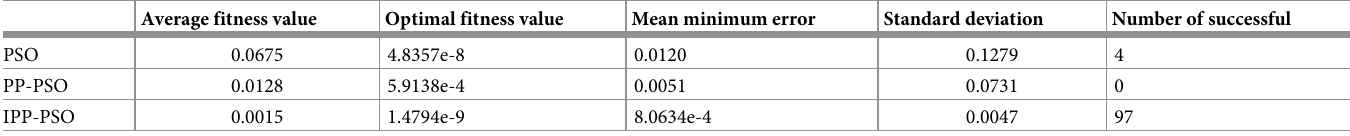
Fig 7. Average error simulation results of two-person zero-sum game. https://doi.org/10.1371/journal.pone.0260231.g007 Table 3. Simulation results of two-person zero-sum game.